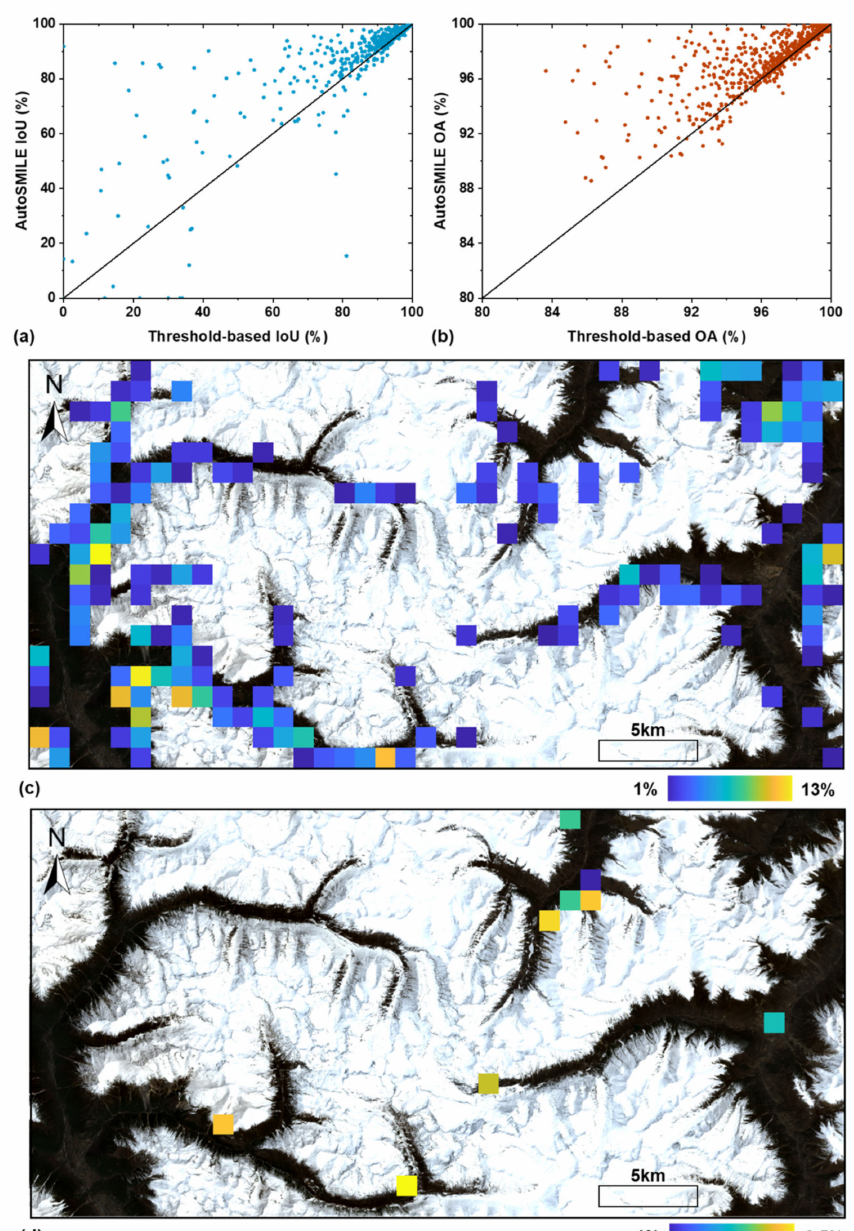
Figure 12. Comparison results between AutoSMILE and the best threshold-based method (NDSI > 0.17) in the study area of Bome County: ( a ) scatter plot of IoUs of 1 × 1 km 2 tiles using the two methods; ( b ) scatter plot of OAs of 1 × 1 km 2 tiles using the two methods; ( c ) OA difference heatmap of 1 × 1 km 2 tiles where OA AutoSMILE − OA threshold > 1% and ( d ) OA difference heatmap of 1 × 1 km 2 tiles where OA threshold − OA AutoSMILE > 1%. (NDSI means the normalized difference snow index, IoU means the intersection over union, and OA means the overall